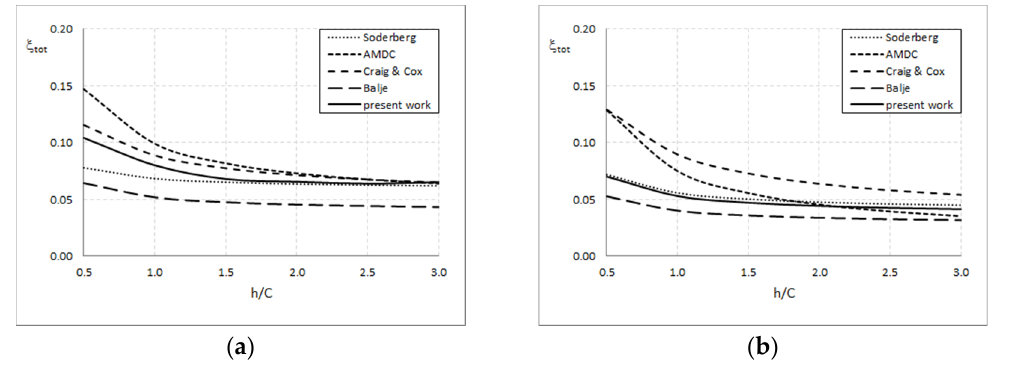
Figure 6. Loss coefficients obtained from the present work compared with traditional estimation methods for ( a ) nozzle blade λ 1 = 90 ◦ and λ 2 = 15 ◦ ; ( b ) nozzle blade λ 1 = 90 ◦ and λ 2 = 30 ◦ .